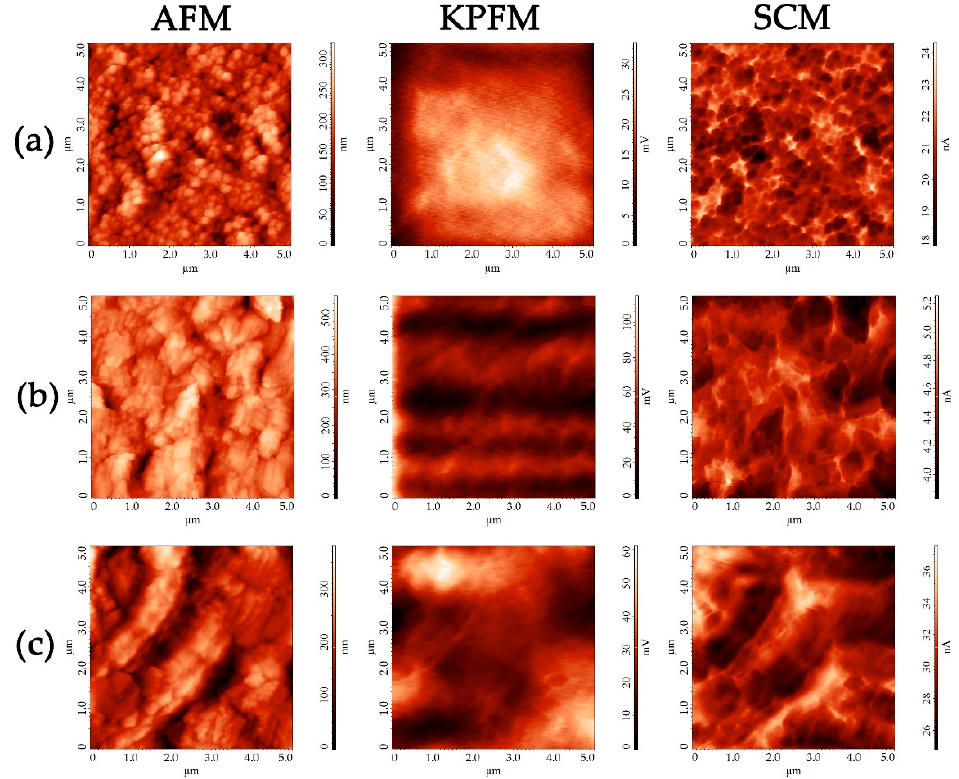
Figure 6. Topography of the coatings deposited sequentially on the Pt/Al 2 O 3 /Pt chip surface (left column), as well as surface potential (center) and capacity gradient (right) distribution maps for NiO-SDC ( a ), (NiO-SDC)/SDC ( b ) and (NiO-SDC)/SDC/(LSCF-SDC) layers ( c ).